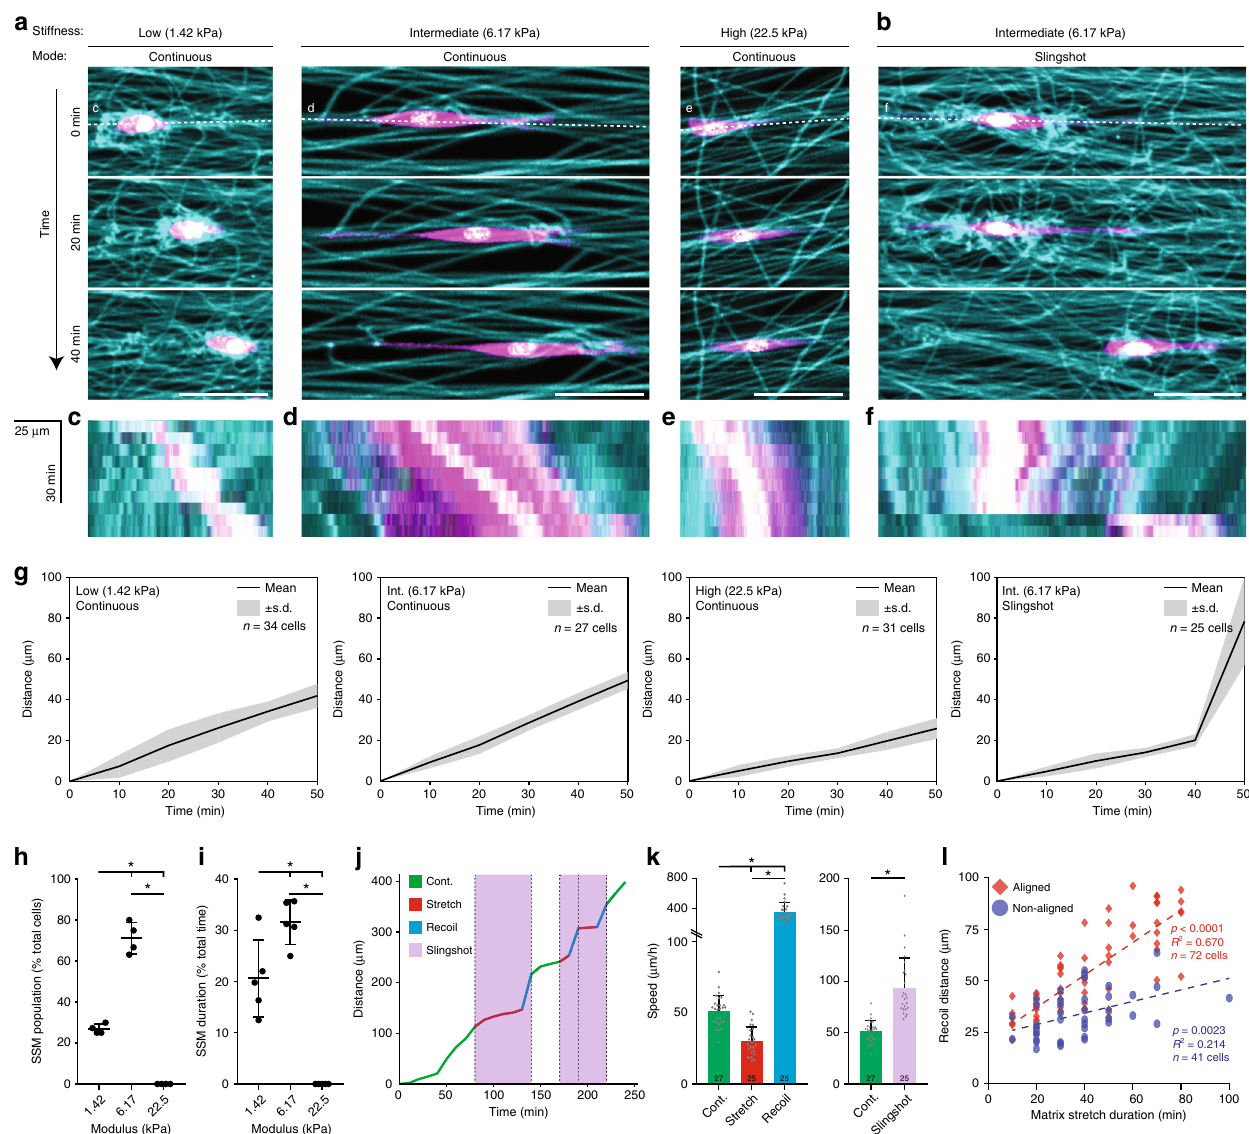
Fig. 3 Aligned deformable matrices undergo marked deformation and promote rapid migratory events. a , b Representative time-lapse images of NIH3T3s within matrices of low, intermediate, and high stiffness utilizing continuous or slingshot migration (SSM) modes (matrix fi bers (cyan), cytoplasm (magenta), and nuclei (white); scale bars: 50 μ m). c – f Corresponding kymographs taken along the dotted lines indicated in a and b . g Migration distance over time for cells undergoing continuous migration and SSM. n = number of cells per group as indicated within each plot; shaded region indicates standard deviation. h Percentage of cells observed to employ SSM out of all cells tracked over a 6 h time course ( n = 4 fi elds of view; fi eld of view = 10 cells). i Percentage of time cells employed SSM as a function of matrix stiffness ( n = 5 fi elds of view; fi eld of view = 10 cells). j Representative migration track of an NIH3T3 on aligned matrix of intermediate stiffness, demonstrating interconversion between continuous migration and SSM modes over its tracked lifetime. k Effective migration speeds of parsed phases of continuous, stretch, and recoil (left) and periods of continuous migration and SSM (combined stretch and recoil phases) (right). Continuous migration speeds were calculated from periods of continuous migration in cells that undergo SSM over its tracked duration. n = number of cells per group as indicated within each bar. l Recoil distance (net translocation of cell) as a function of duration spent stretching the matrix ( n = number of cells per group as indicated within the plot). Dashed lines indicate linear correlations with indicated R 2 and p -values. All data presented as mean ± s.d.; * indicates a statistically signi fi cant comparison with p < 0.05 ( h , i , k : one-way analysis of variance, l: linear regression)